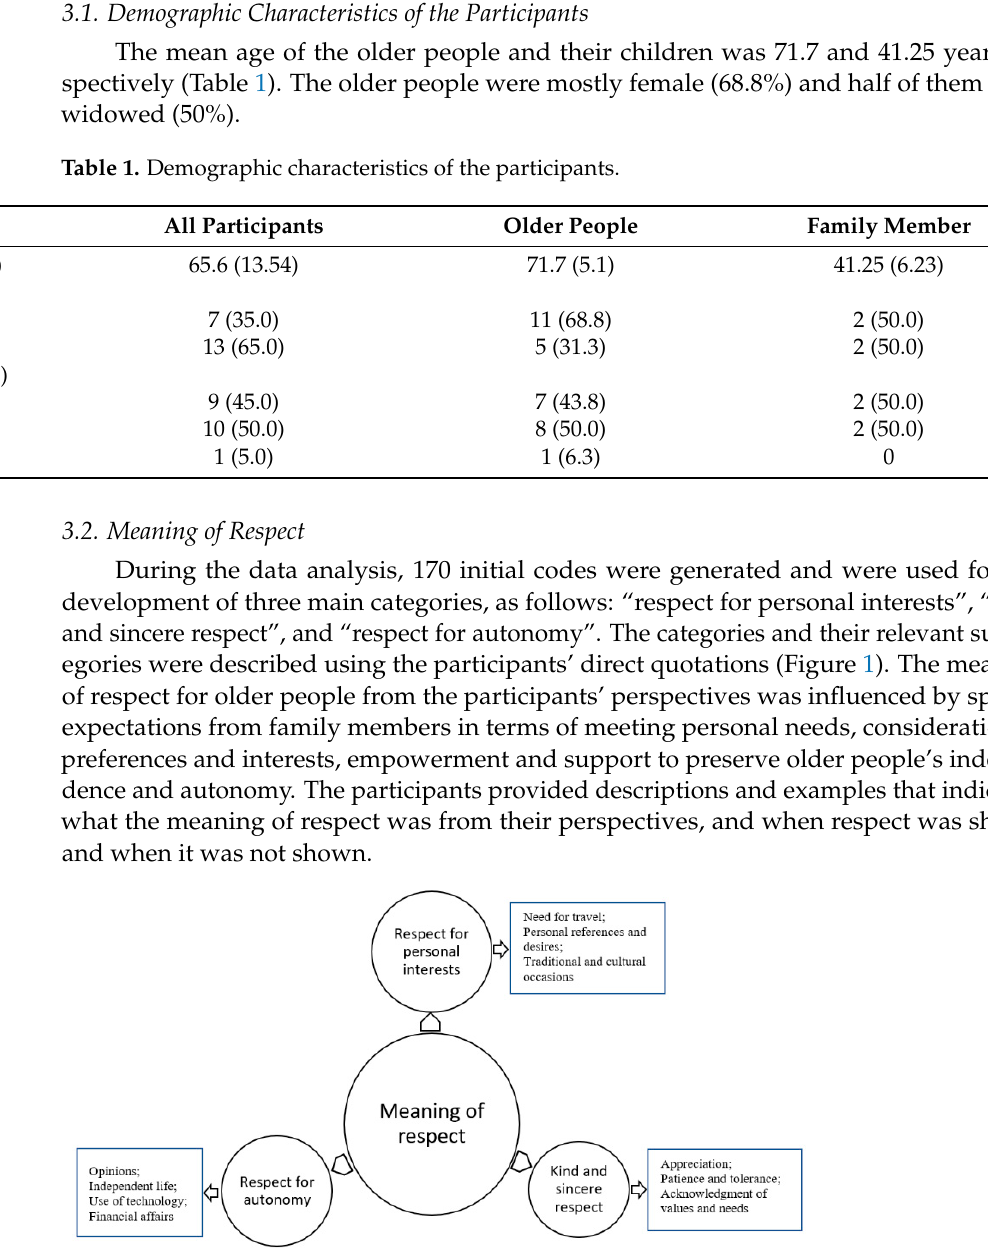
Figure 1. Meaning of respect for older people in family relationships from the participants’ per-